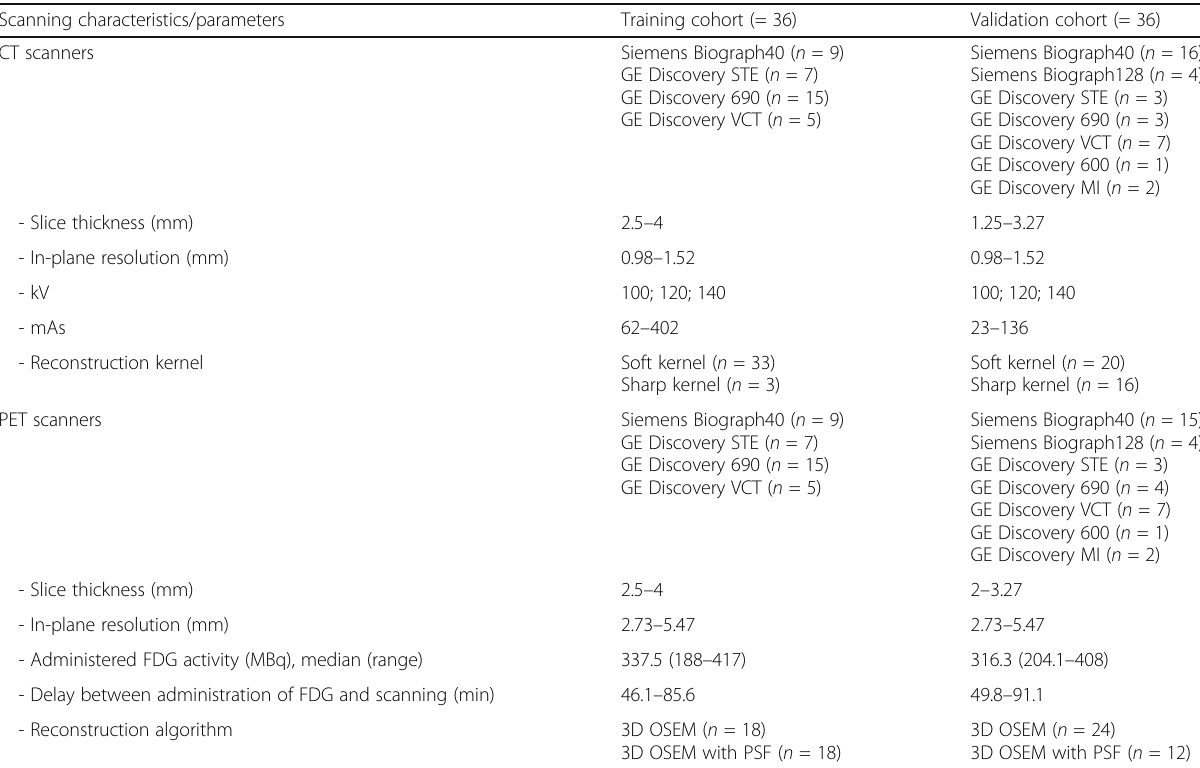
Table 2 Scanning parameters Scanning